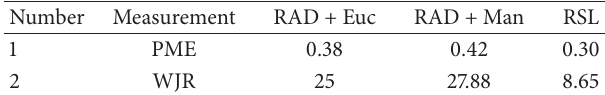
Table 6: Performance for path B under pattern b